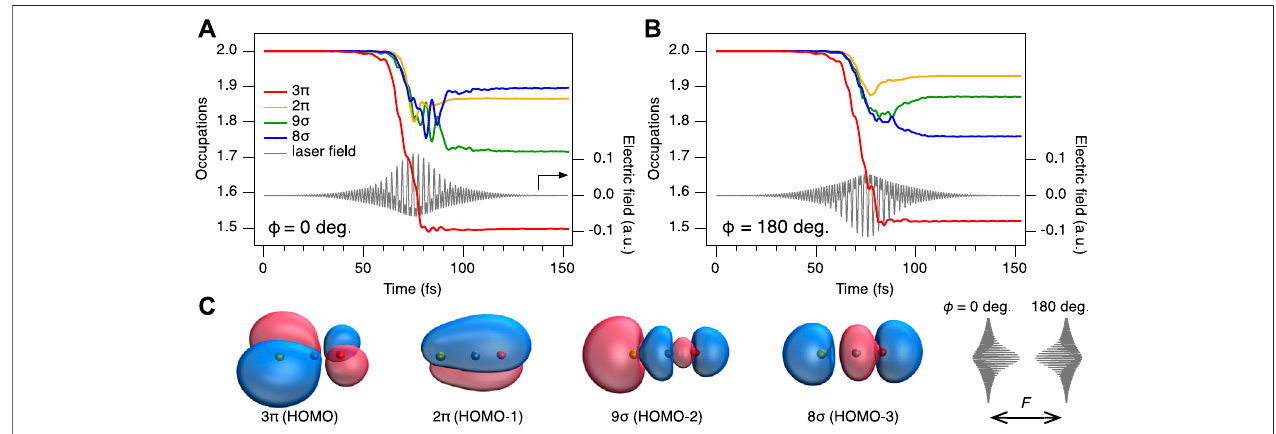
FIGURE6| ResultsofthertTDDFTcalculations. (A) Time-dependentorbitaloccupationsfor ϕ =0 ° . (B) samefor ϕ =180 ° .Thetemporalshapesoftheelectric fi elds are shown as solid grey lines. Note that 3 π and 2 π are doubly degenerate. (C) Orbitals of HOMO to HOMO-3. HOMO and HOMO-1 are π orbitals, while HOMO-2 and HOMO-3 are σ orbitals. For π orbitals, only one variant is shown, the other variant is a simple rotation around the molecular axis by 90 ° . Yellow atom indicate sulfur, blue atoms=carbonandredatoms=oxygen. F denotesthelaserpolarizationdirection.Schematicshapesofthephase-lockedtwo-colorlaserelectric fi elds( ϕ =0 ° and 180 ° ) are